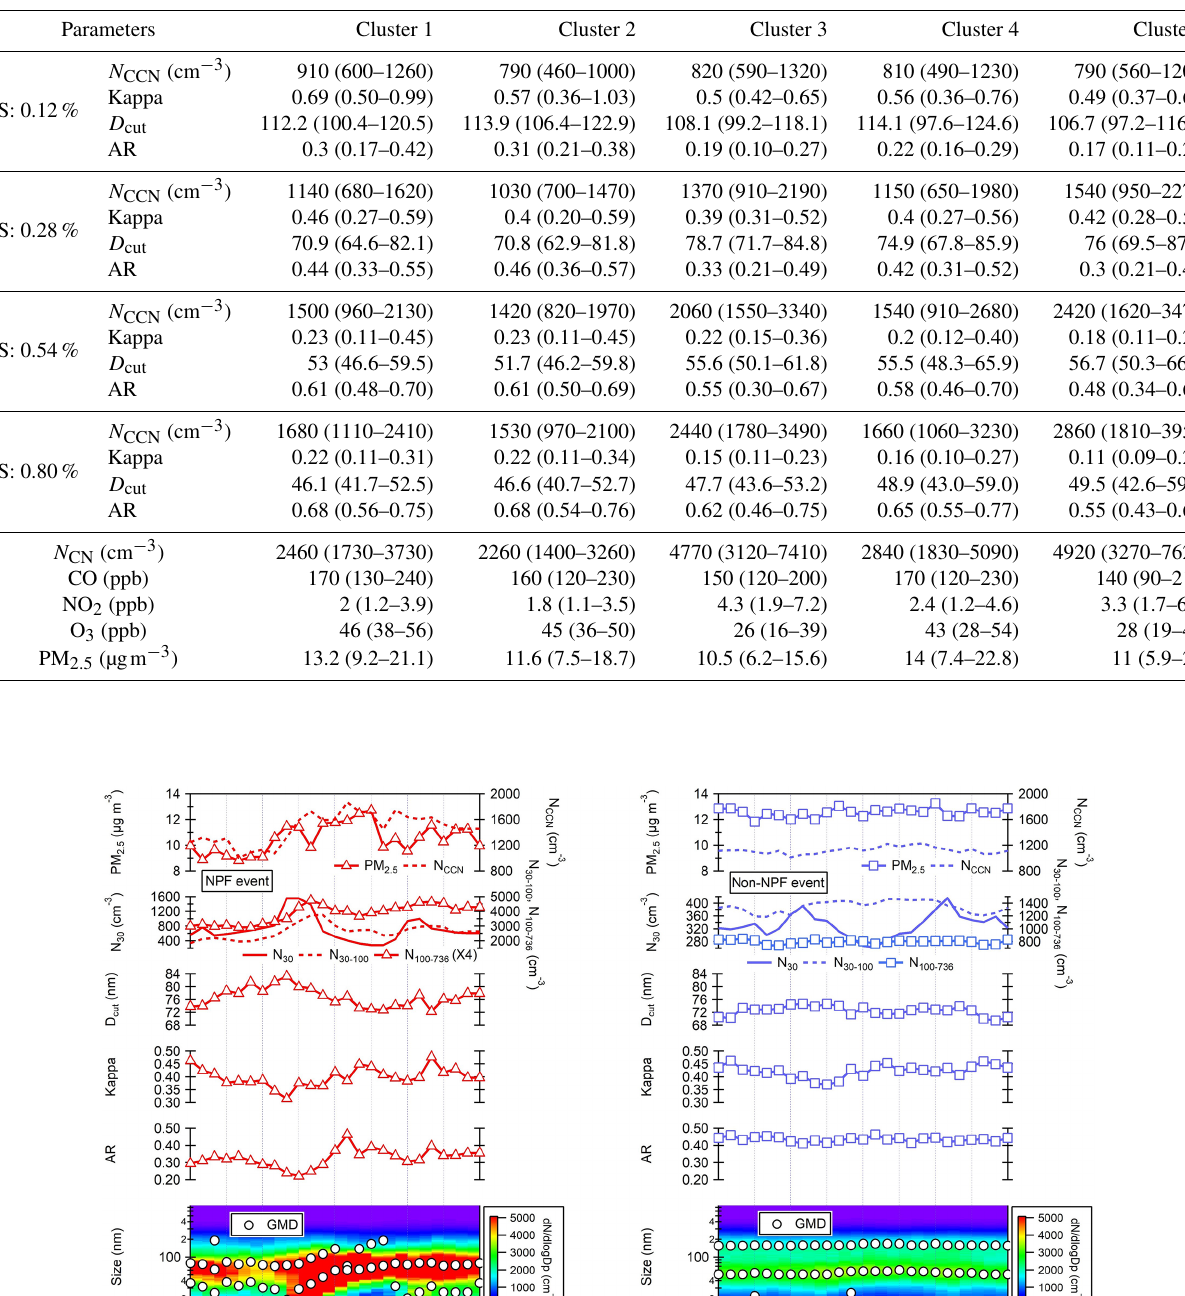
Table 3. Statistics for the number concentration of cloud condensation nuclei ( N CCN ), kappa value ( κ ), activation diameter ( D cut ), activation ratio (AR) and concentrations of major air pollutants (i.e., CO, NO 2 , O 3 and PM 2 . 5 ).